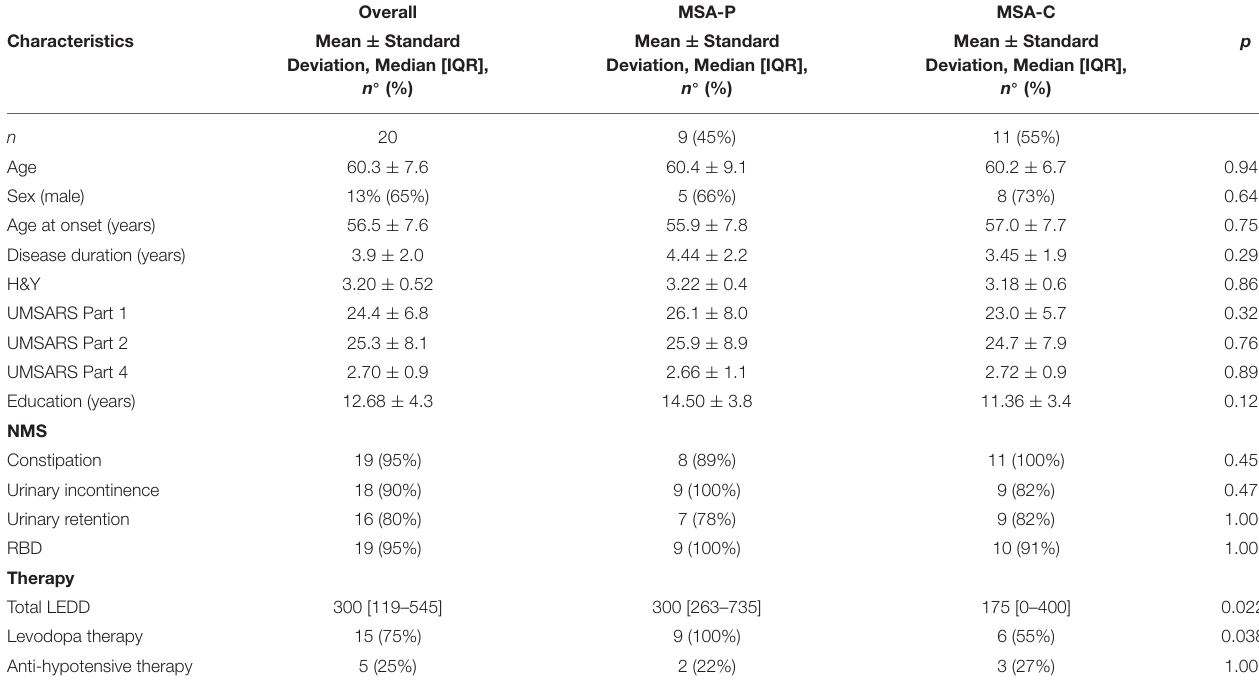
TABLE 1 | Demographic and clinical features of MSA-P and MSA-C patients. Overall